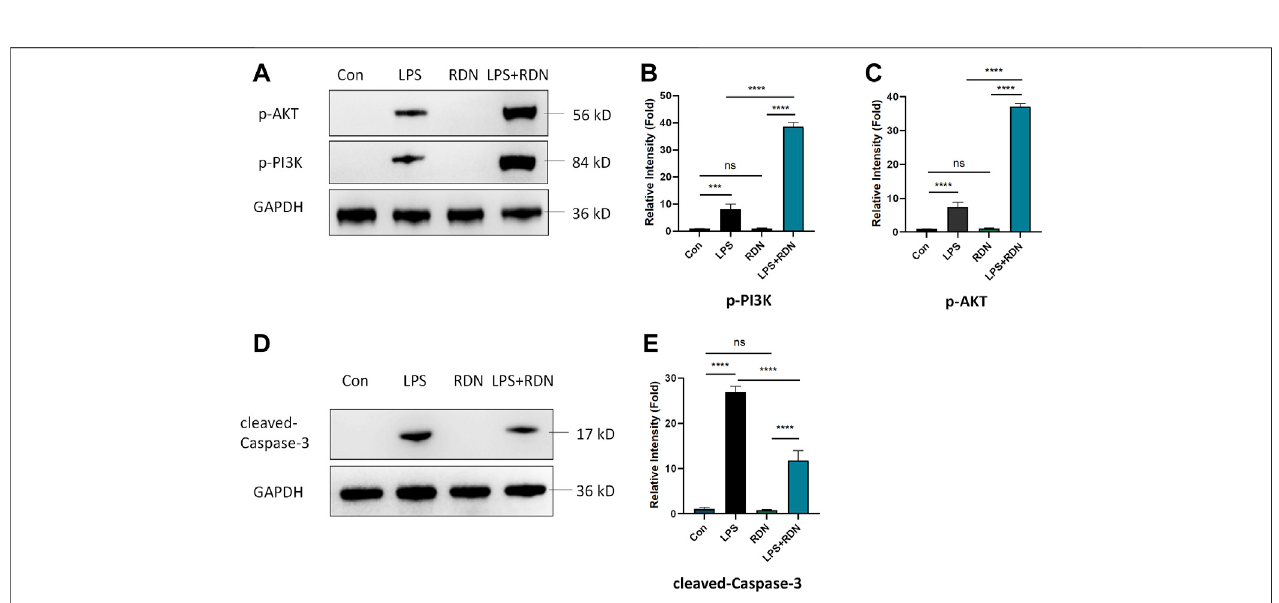
FIGURE 6 | RDN could interfere with PI3K-AKT-Caspase-3 signaling pathway in LPS-induced HUVECs. (A-C) Western blot was employed to detect the effect of RDN on PI3K-AKT signaling pathway. (D,E) The protein expression of cleaved-Caspase-3 in HUVECs was analyzed by western blotting. The results were quanti fi ed by densitometry. Data are presented as mean ± SD ( n = 3 per group) of the representative data from three independent experiments; *** p < 0.005, **** p < 0.001.